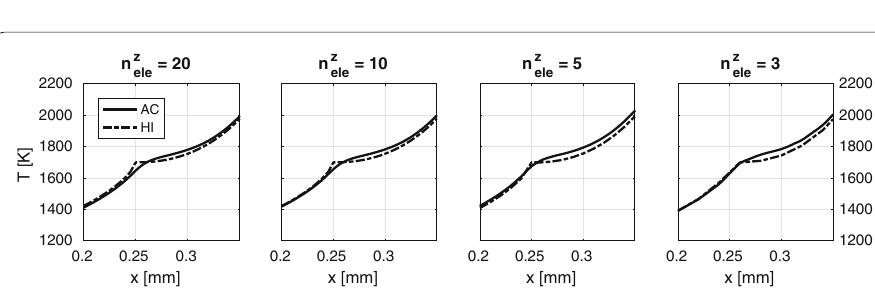
Fig. 17 Surface temperature profiles for AC and HI along laser path (i.e. y = 0 . 0mm) for different spatial discretizations. Zoomed in to melting front of melt pool